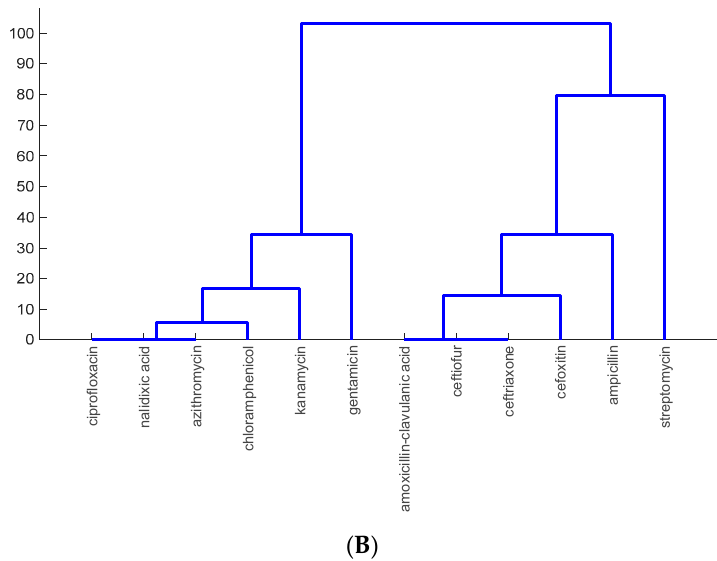
Figure 3. An illustrative example of hierarchical clustering: ( A ) projections of antimicrobials amoxicillin-clavulanic acid, ampicillin, azithromycin, cefoxitin, ceftiofur, ceftriaxone, chloramphenicol, ciprofloxacin, gentamicin, kanamycin, nalidixic acid, and streptomycin onto the PC1–PC2 space on the basis of the resistance of these antimicrobials in foodborne pathogens; ( B ) clustering the antimicrobials on the basis of their projections in ( A ). Table 1. Antimicrobials to which pathogens are most resistant (indicated by PCA and hierarchical clustering for states PA, NY, MD, NM, MN, and CA). States Antimicrobials